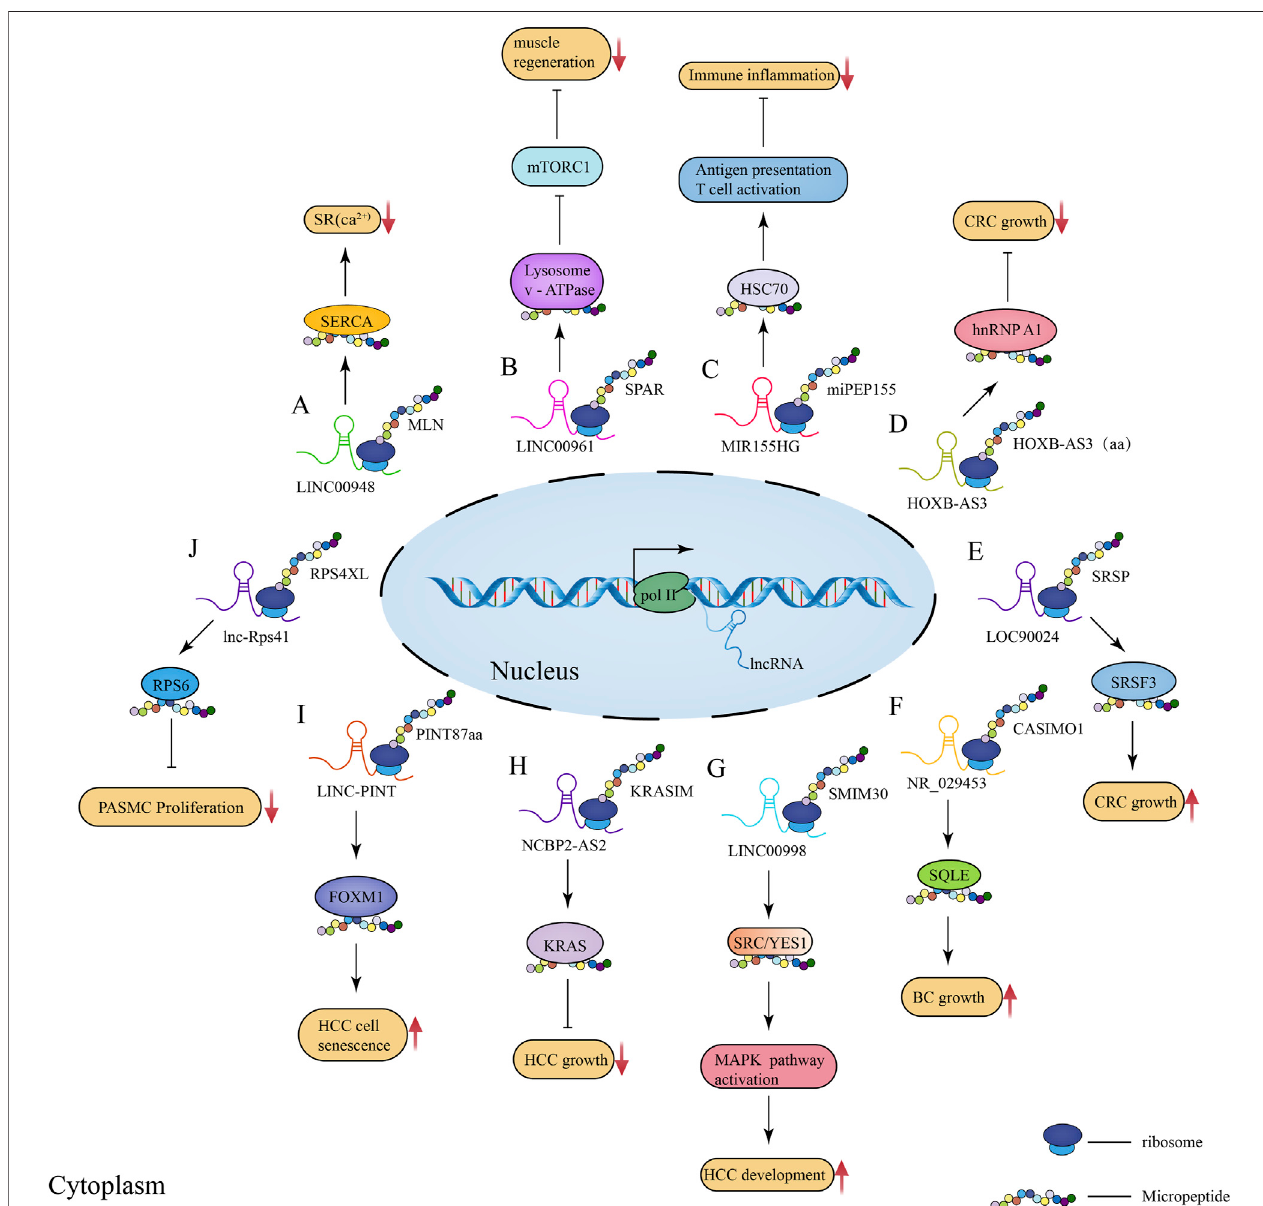
FIGURE2| SchematicillustrationoftheregulatoryroleoflncRNA-encodedmicropeptidesinmusclephysiologicalprocessesaswellasdiseaseandtumorigenesis and development. (A) Mechanism of action diagram of micropeptide MLN encoded by lncRNA LINC00948 in skeletal muscle physiological process; (B) Mechanism of action diagram of conserved peptide SPAR encoded by lncRNA LINC00961 in muscle regeneration process; (C) Mechanism of action diagram of micropeptide miPEP155 (P155) encoded by lncRNA MIR155HG in immunity and in fl ammation; (D) Mechanism of action diagram of the 53-aa conserved peptide encoded by lncRNA HOXB-AS3 in CRC; (E) Mechanism of action diagram of the micropeptide SRSP encoded by lncRNA LOC90024 in CRC; (F) Mechanism of action diagram of the micropeptide CASIMO1 encoded by lncRNA NR_029453 in BC; (G) Mechanism of action diagram of the conserved peptide SMIM30 encoded by LINC00998 in HCC; (H) Mechanism of action diagram of the 99-aa conserved peptide KRASIM encoded by lncRNA NCBP2-AS2 interacting with KRAS in HCC; (I) Mechanism of action diagram of the micropeptide PINT87aa encoded by LINC-PINT interacting with FOXM1 in HCC cell senescence; (J) Mechanism of action diagram of the micropeptide RPS4XL encoded by lnc-Rps41 interacting with RPS6 in PASMC.